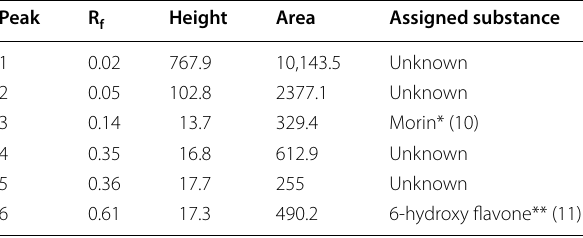
*,**When compared in similar conditions[22, 23]